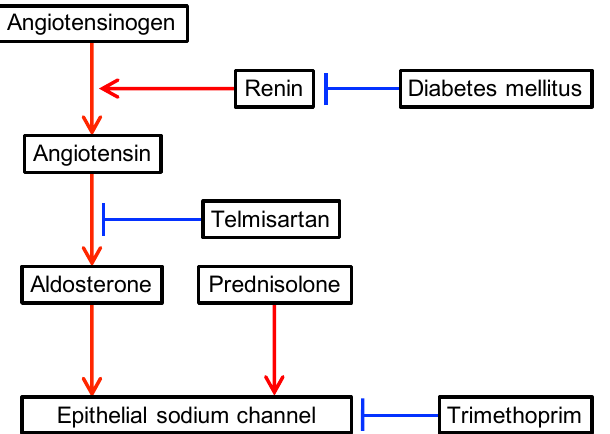
Figure 2. Factors influencing the renin–angiotensin–aldosterone system. Red and blue arrows indicate positive and negative regulatory effects, respectively.